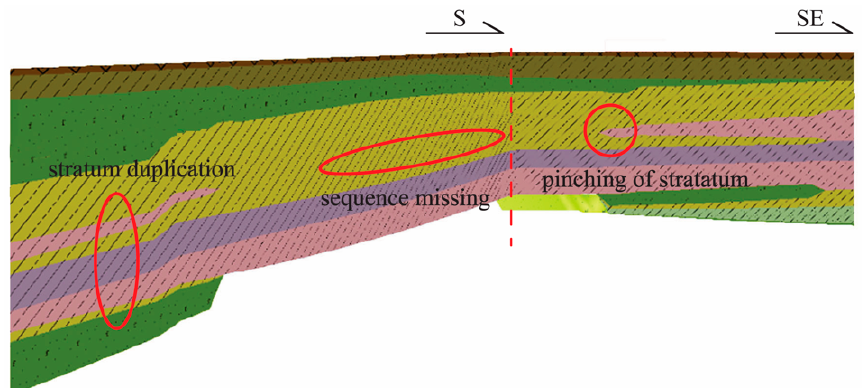
Figure 9. Interpolation viewpoint along the profile.